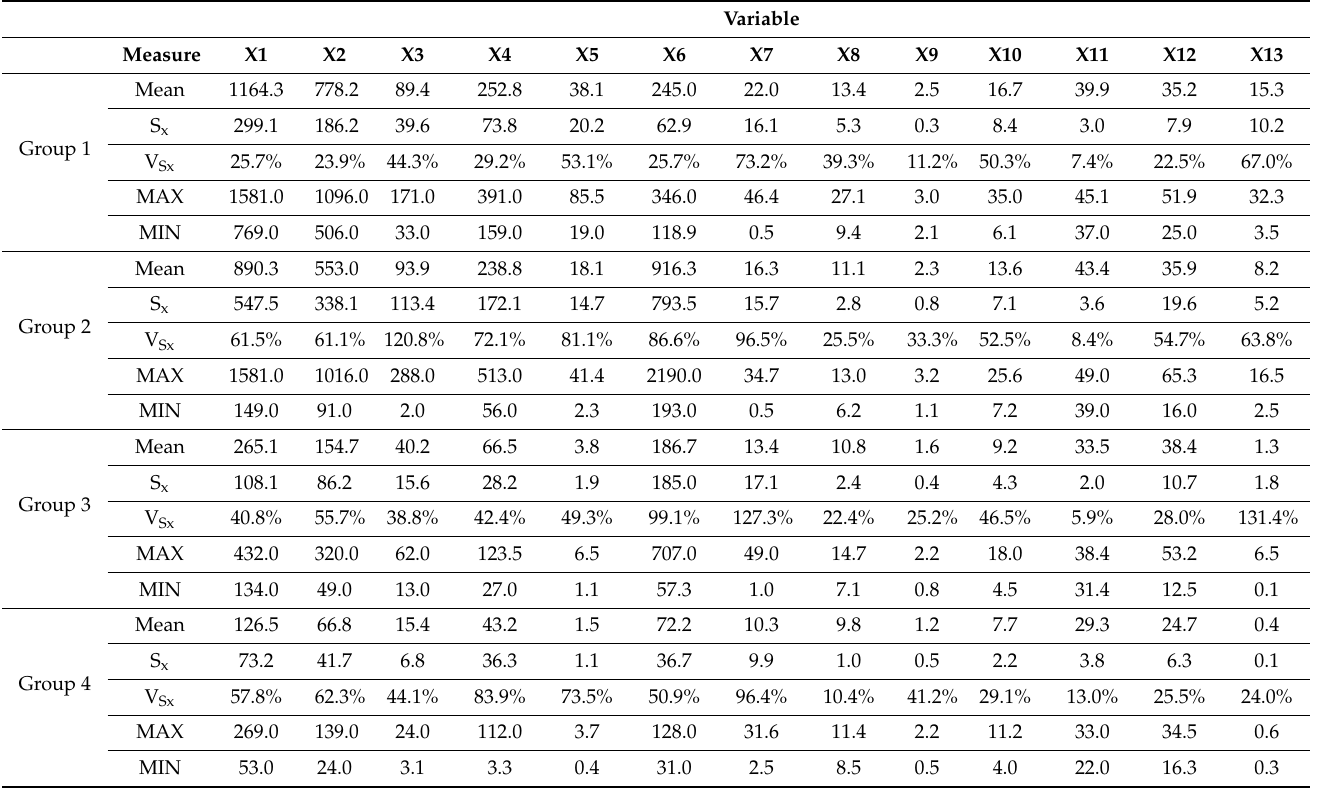
Table 7. Comparison of selected measures of descriptive statistics for individual groups in